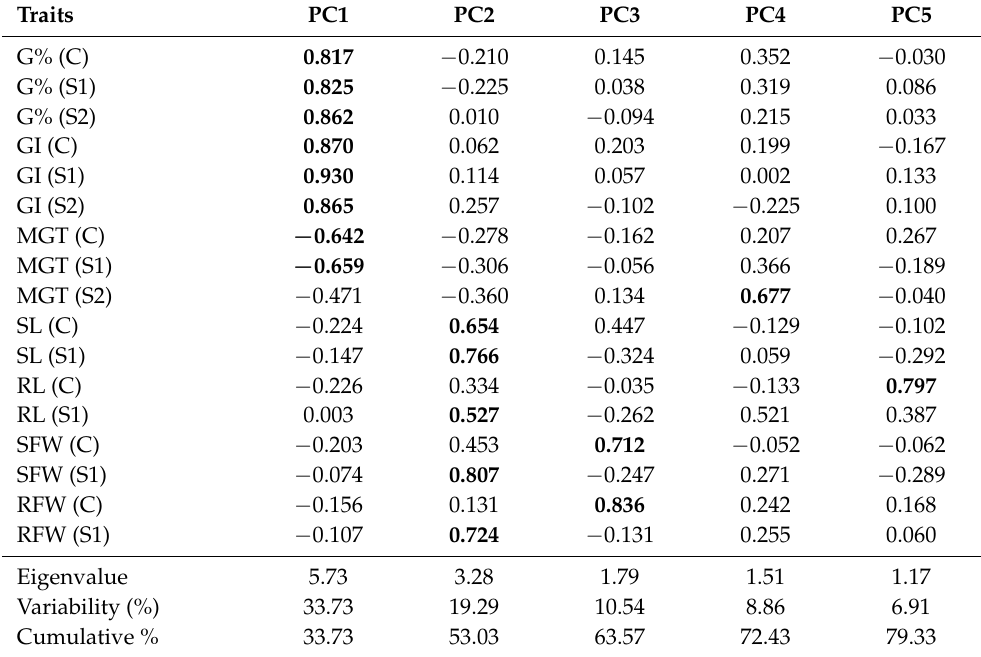
Table 5. Eigen value, cumulative variability, and factor loadings of the first five principal components (PCs) for different germination and seedling traits measured under control and salinity conditions of all barley